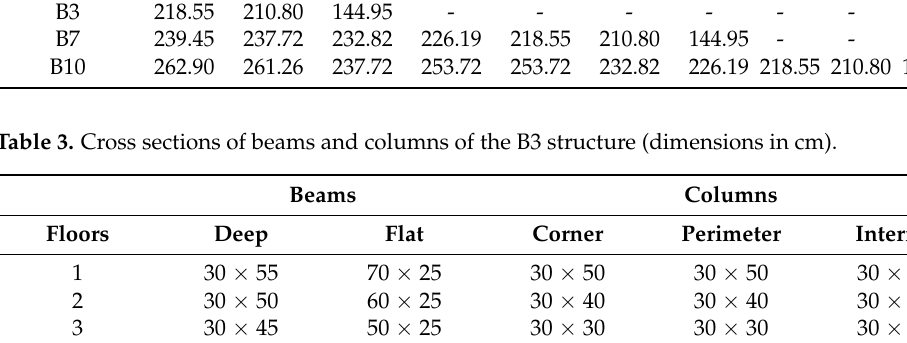
Table 2. Floor masses of the B3, B7 and B10 test structures (dimensions in kNs 2 /m). Structures